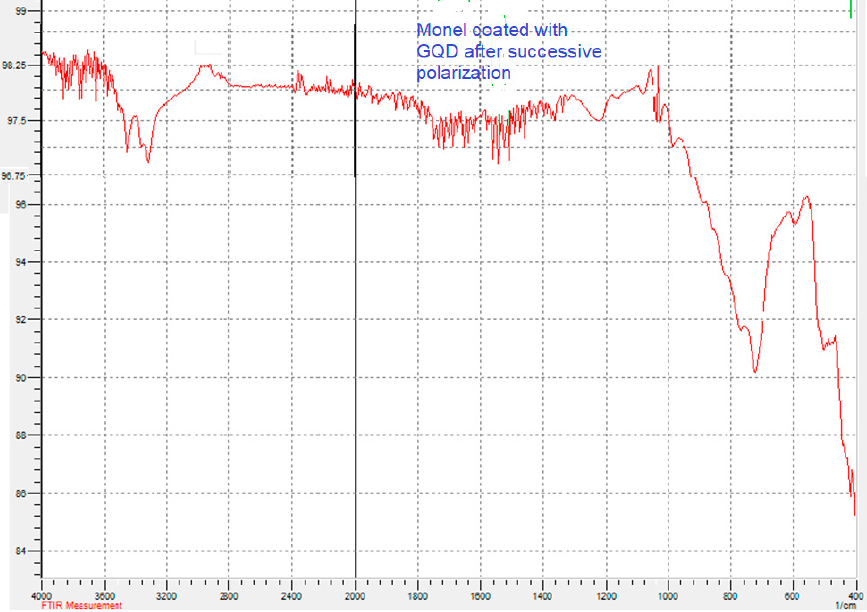
Figure 5. FTIR spectrum of Monel coated with graphene upon successive polarizations.